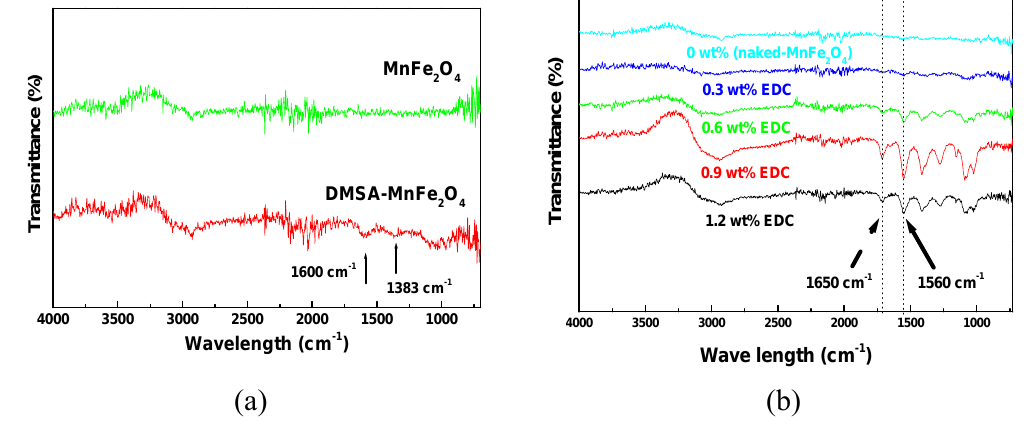
Figure 4. TGA curves of chitosan-MnFe